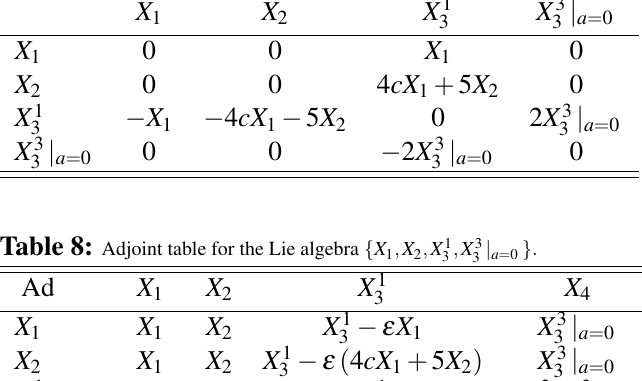
1 | a = 0 } . , X 3 1 , X 2 , X 3 3